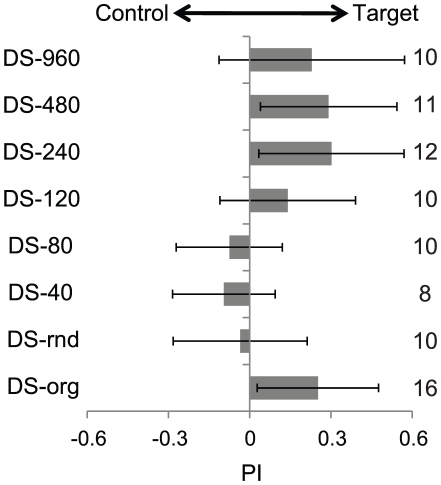
The effect of dance sound components on sound source discrimination.The numbers to the right of the grey bars indicate the number of honeybees tested. The error bars indicate standard deviations. The left column indicates the types of dance sounds: DS-org is the original dance sound, while DS-rnd and DS-n (n = 40–960, interval time [msec]) are synthetic dance sounds. The intervals in DS-rnd were randomly set between 40 msec and 960 msec. The mean interval length in DS-org was about 480 msec. The grey areas show the mean performance indices (PI) the 22-sec flight periods. PI is calculated for the periods as a ratio of (t1−t2)/(t1+t2), where t1 indicates the duration during which the honeybee orients towards the current dance sounds and t2 indicates the period during which the honeybee orients towards the flight sounds. Starting positions of sound sources were shifted randomly. Since PI's are 0.25±0.22, 0.30±0.27, 0.29±0.25, and 0.23±0.34 for dance sounds DS-org, DS-240, DS-480 and DS-960, respectively, their non-zero hypotheses are significant with P<0.01 (DS-org, DS-240 and DS-480) and P<0.05 (DS-960). On the other hand, since PI's are −0.03±0.25, −0.09±0.19 and −0.07±0.20 for dance sounds DS-rnd, DS-40, and DS-80, respectively, the non-zero hypothesis is not significant with p>0.05.